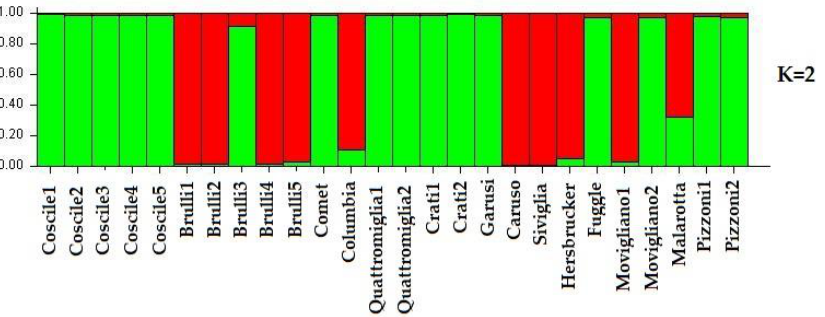
Figure 5. Bayesian individual clustering based on 8 SSR datasets of 22 hops populations from 3 different areas and of 4 commercial varieties (Comet, Comet, Fuggle, Columbia, and Hersbrucker) as inferred by STRUCTURE (Group 1 = green; Group 2 = red).